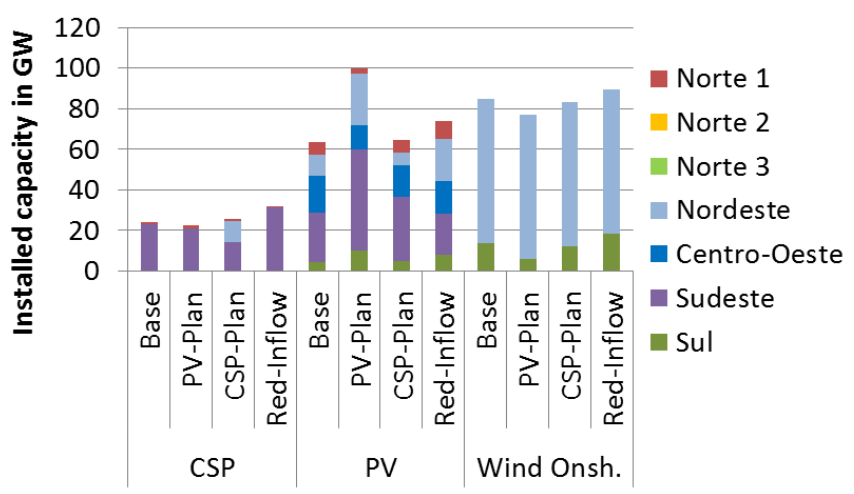
Figure 5. Scenario comparison of calculated regional solar and wind power generation capacities in 2050.